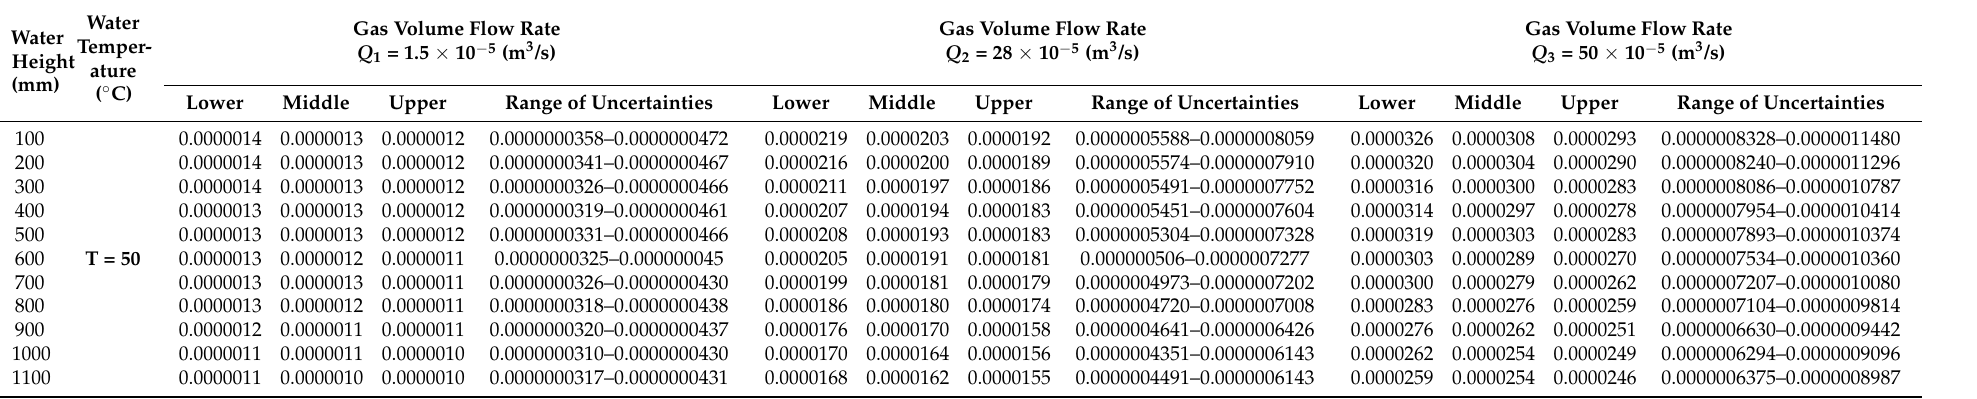
Table 13. Void fraction α as a function of water height for a water temperature of 50 ◦ C and for gas volume flow rates Q 1 –Q 3